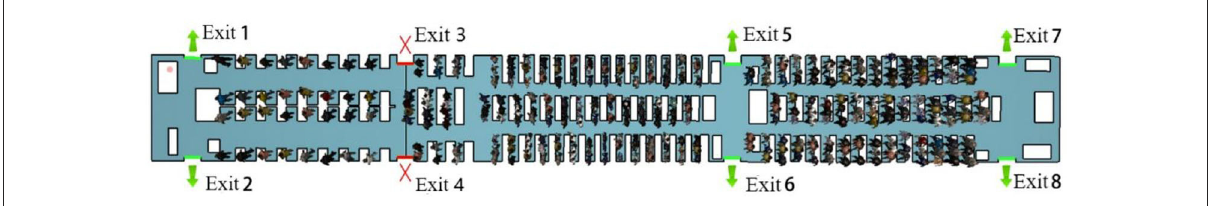
FIGURE13 Schematic diagram of passenger cabin evacuation model.